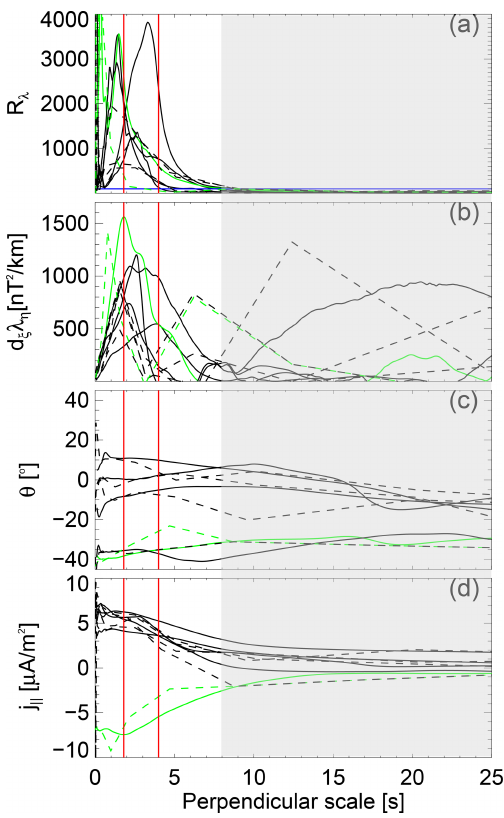
Figure 15. Same panels as in Fig. 6. Solid/dashed lines indicate the profiles for the linear-/logarithmic-scale sampling scheme. The vertical red lines indicate the domain of scales identified by ∂ ξ λ η for the upward (green) and downward (black)